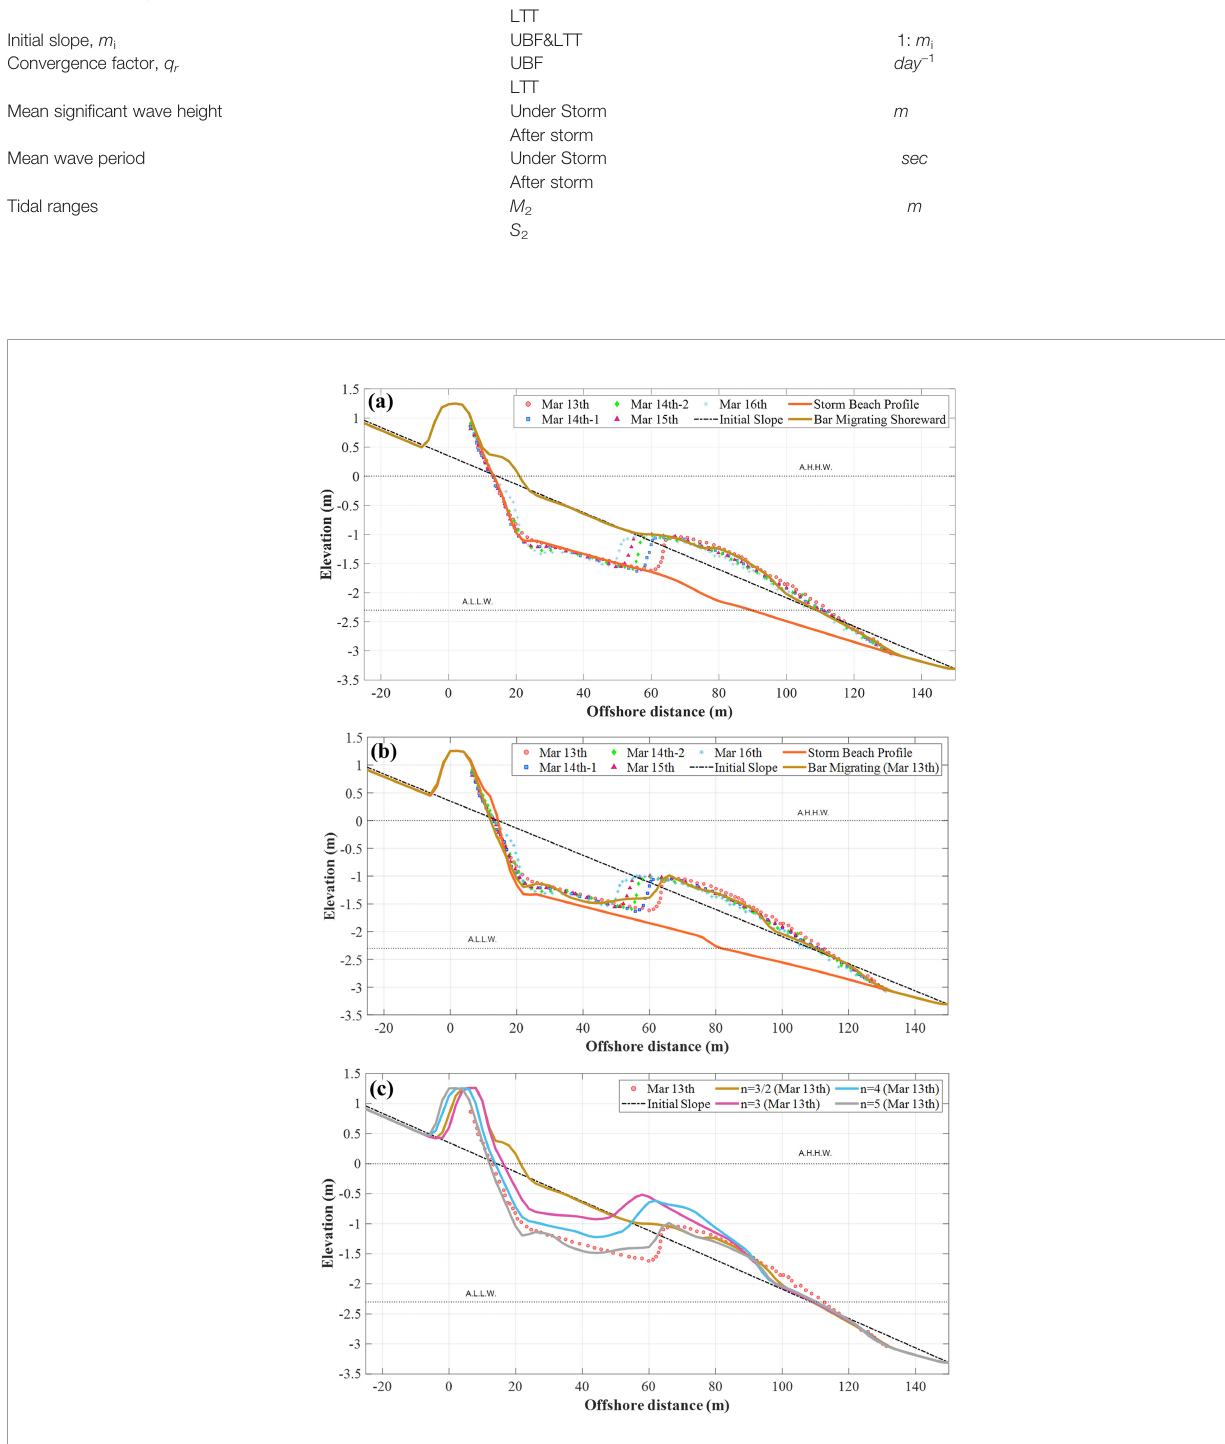
FIGURE 12 | (A) Model results of scarp and bar formation from initial slope, (B) model results simulated with 5th power in Eq. (12) and (C) variation of bar shape according to n